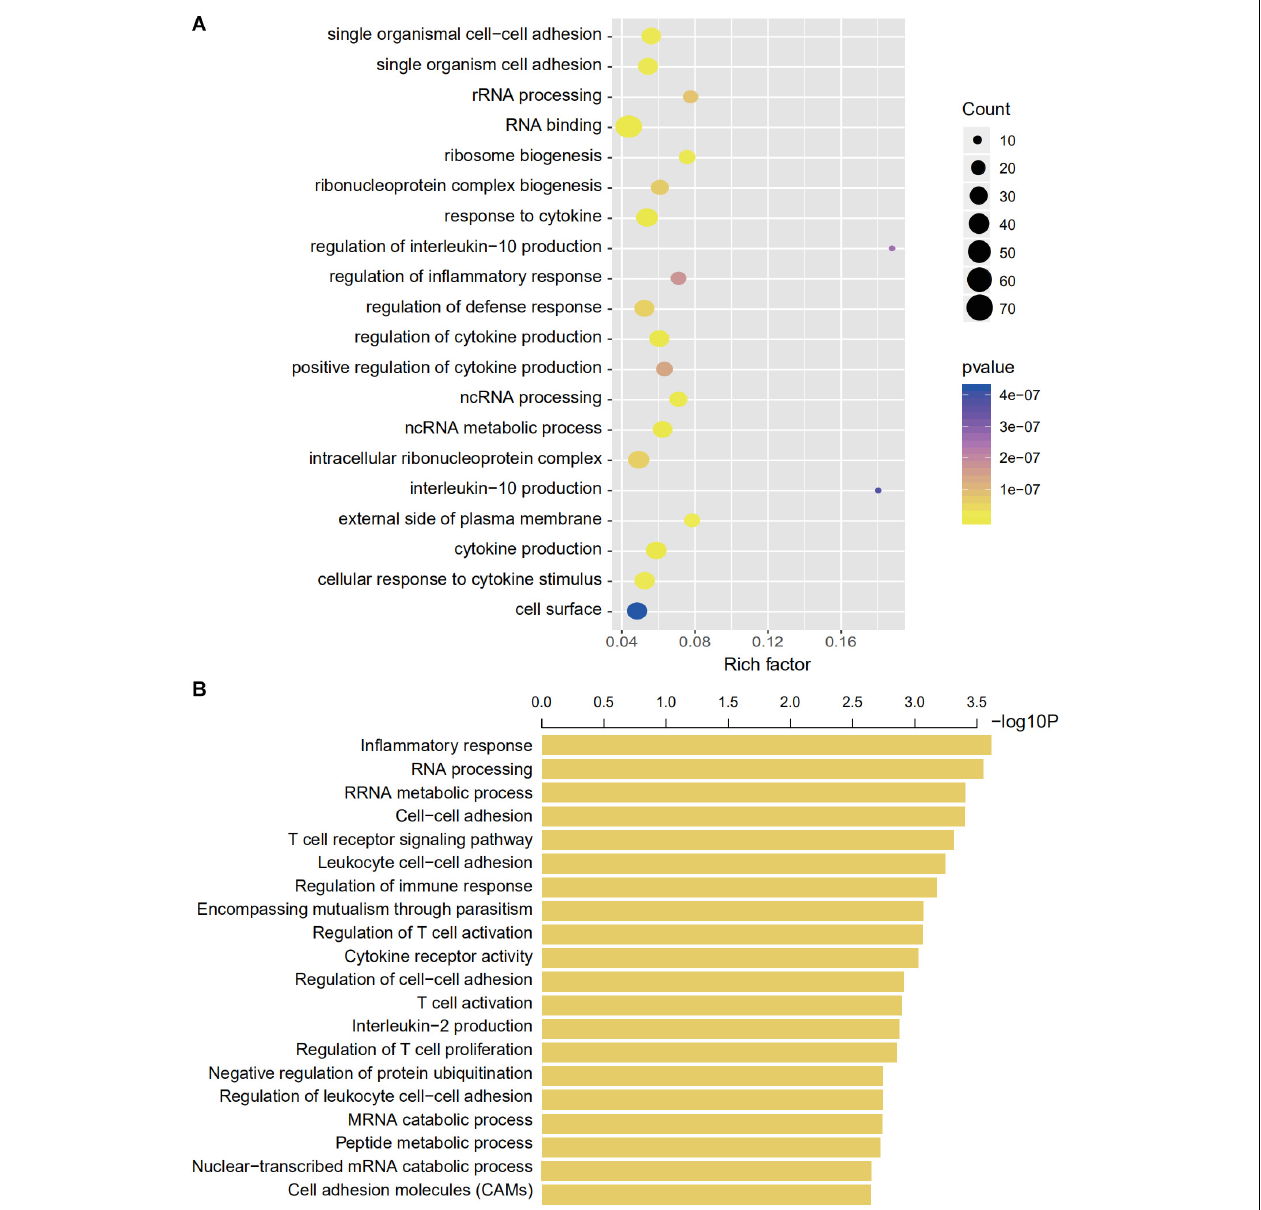
FIGURE 6 | Gene enrichment and functional analyses using co-expressing genes. (A) Gene enrichment analyses using co-expressing genes. The colors of the dots represent the statistical correlation with the selected IRGs. The size of the dots indicates the number of associated genes. (B) Functional enrichment analyses of co-expressing